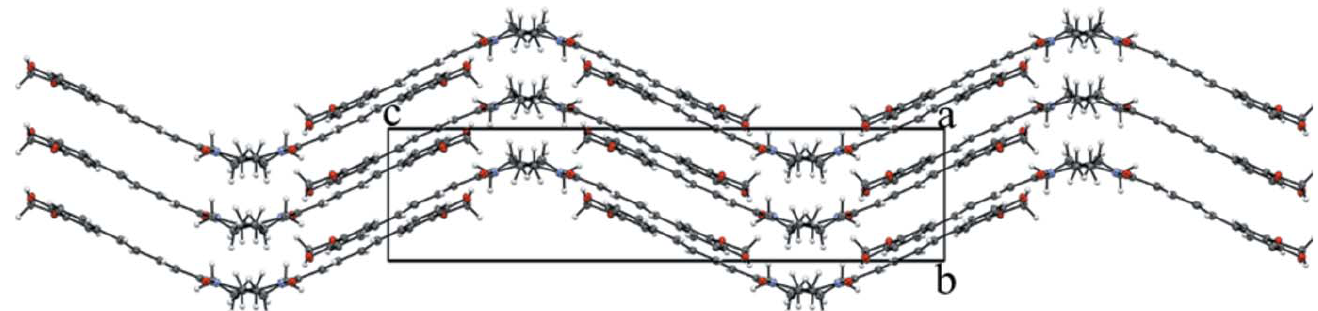
Figure 7 The unit-cell packing for (II) viewed down